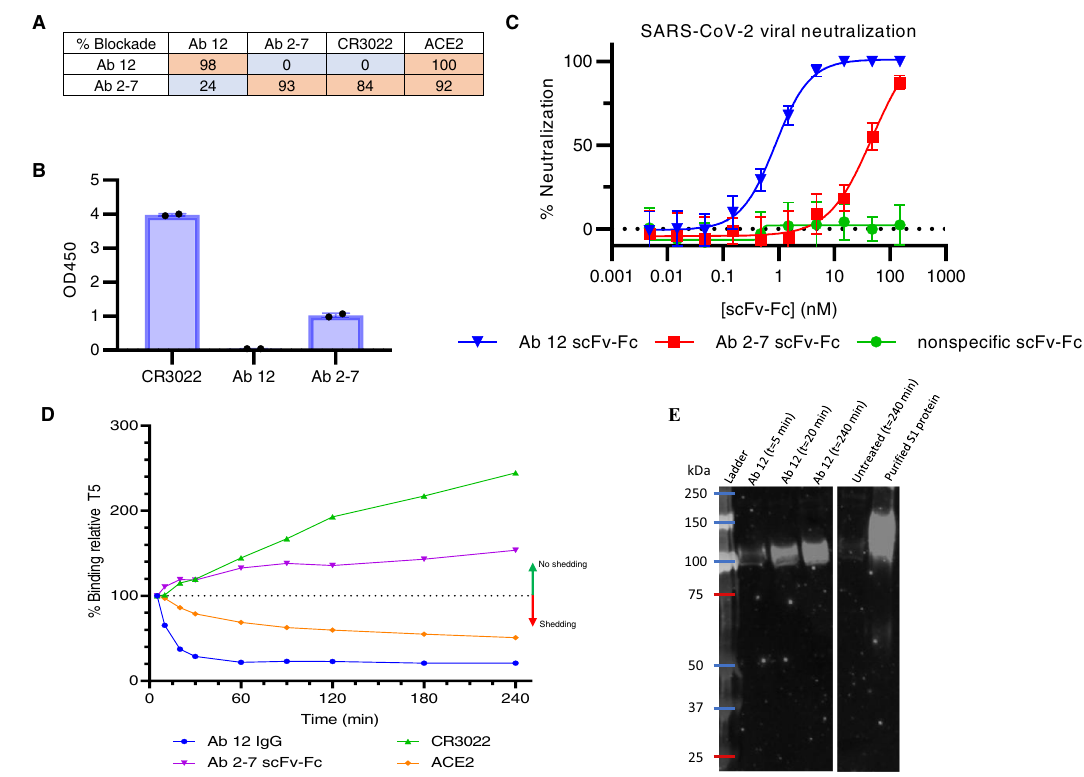
Fig.1|BiochemicalcharacterizationofAb12andAb2-7scFv-Fcs.A Competition matrixshowingpercentblockadeofCR3022andACE2bindingtoSARS-CoV-2RBD. B Antibodybindingat2ug/mlwasmeasuredbyELISAagainstTor2SARS-CoVspike (Toronto,2003). n =2biologicallyindependentsamplesandthemeanispresented. C PRNT neutralization assays performed with SARS-CoV-2 (isolate USA ‐ WA1/2020) demonstratethatAb12isthemorepotentofthetwoscFv-Fcs.Samplesweretested as 3 biologically independent samples with 3 technical replicates per sample and the data is presented as the mean with standard deviation. D FACS based